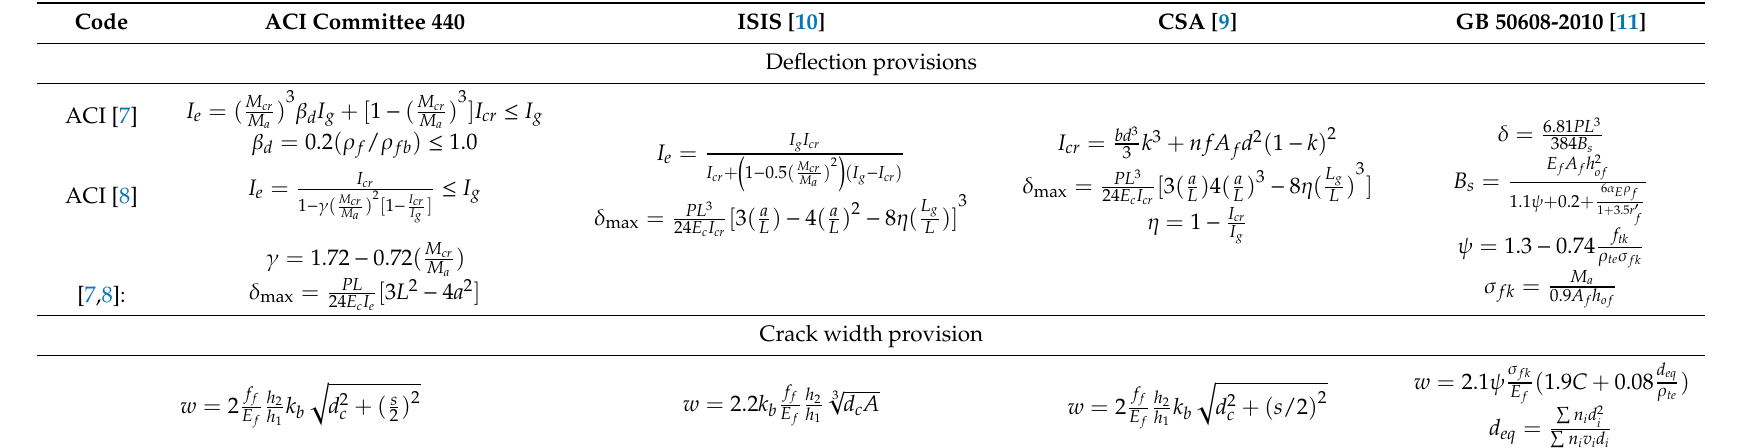
Table 5. Deflection and crack width